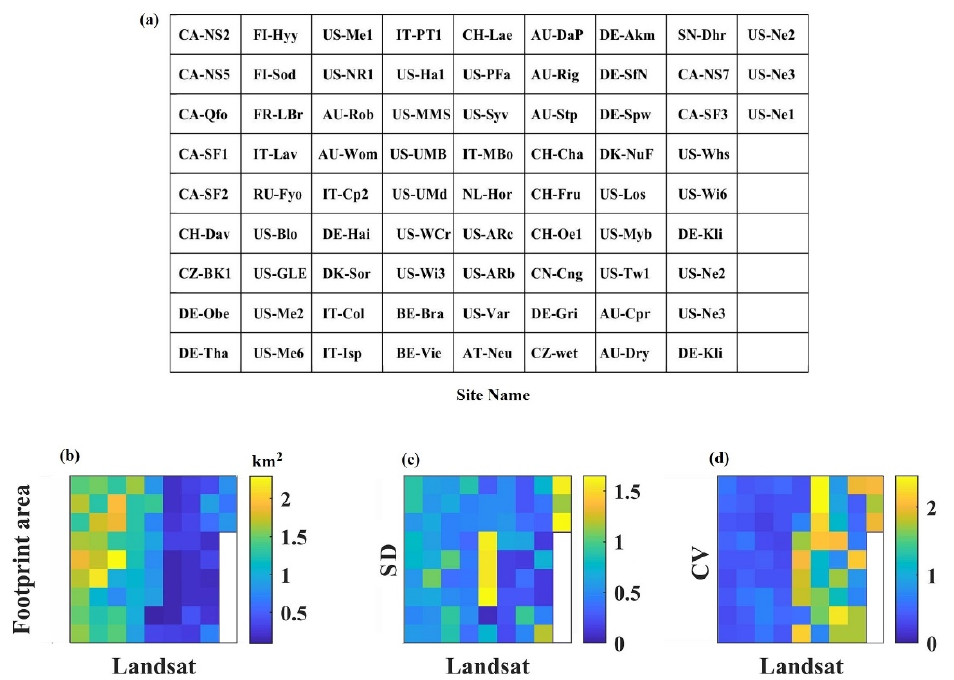
Figure 3. ( a ) Site names for each of the 78 sites. The site names listed in ( a ) correspond with the grids of ( b – d ), such that site CA-NS1 is in the top corner and site US- Ne1 is in the final grid column just above the white line. The abbreviation of each site can be found in Table S1. ( b ) the mean footprint area of each site, ( c ) standard deviation (SD) of footprint area of each site; ( d ) the coefficient of variation (CV) of footprint area at each site. The site name of ( a ) corresponds with the grid of ( b – d ).